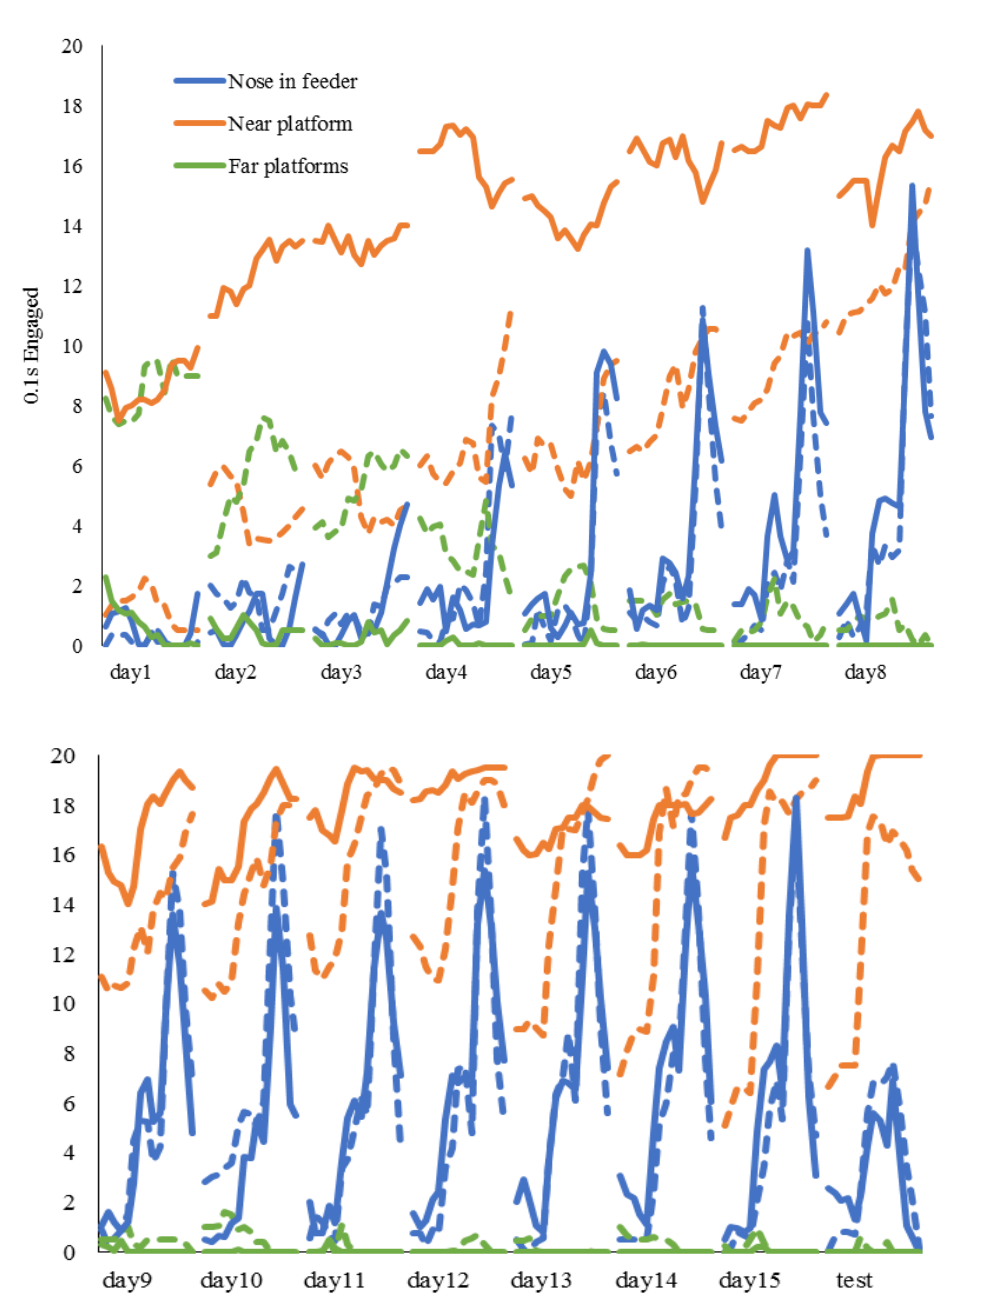
Figure A2. Responding in Experiment 3, prior to, during, and after moments of conditional stimulus presentation (10s periods) in 2s periods over the 15 days of training and ultimate test session. Dotted lines indicate Group INT; solid lines indicate Group